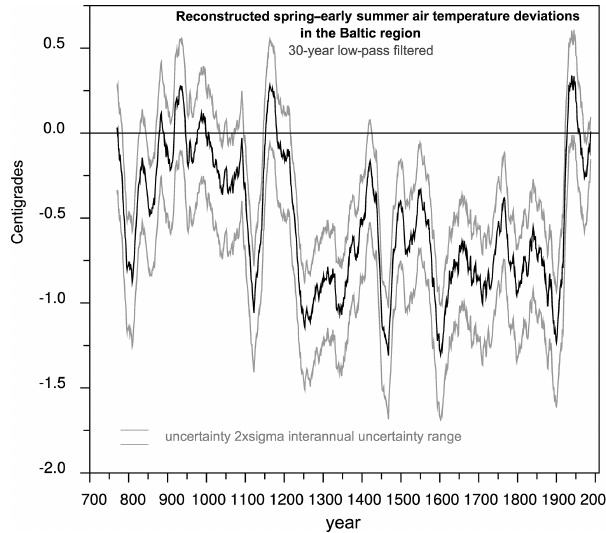
Figure 4. Reconstructed spring–early summer air temperature devi- ations in the Baltic Sea region (land areas in the box 0–40 ◦ E × 55– 70 ◦ N; deviations from the 20th century mean). The record is smoothed by a 30-year low-pass filter. The approximate uncertainty range has been estimated here from the data provided by the original publication at interannual and grid cell scale. Data source: Luter- bacher et al.